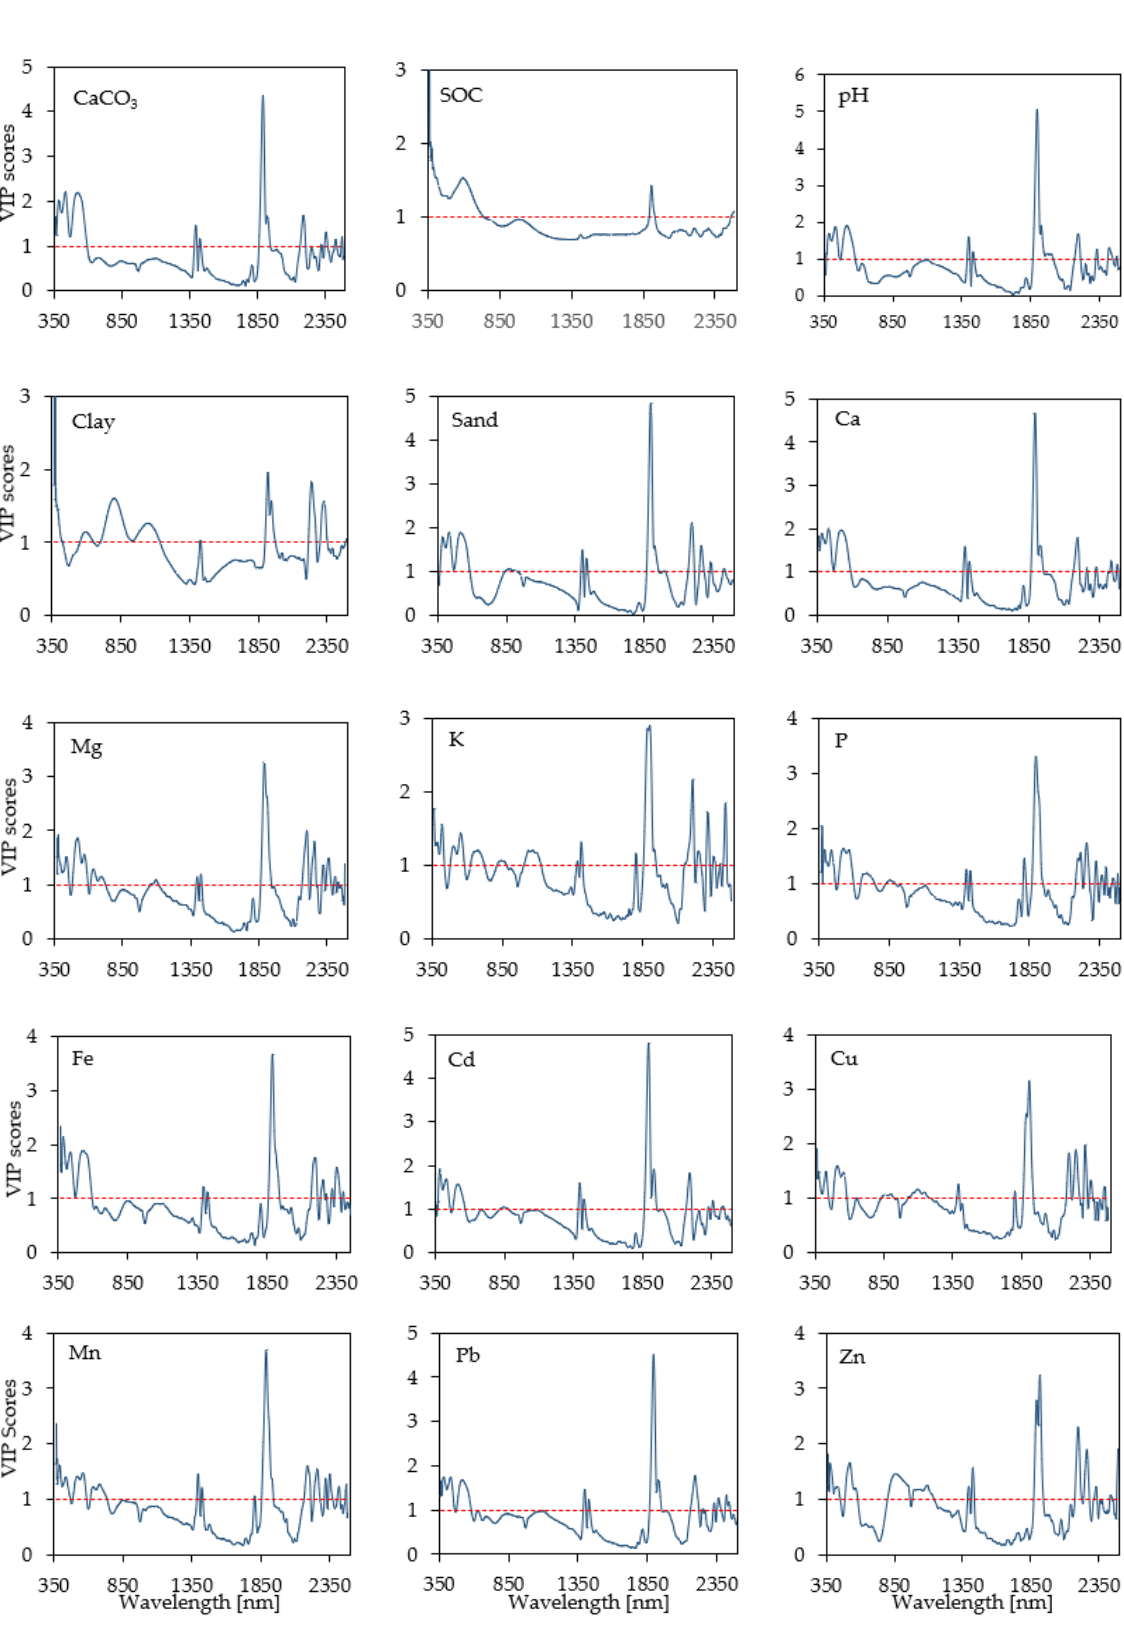
Figure 5. Variable importance in projection (VIP) scores associated with the PLSR models for the soil properties. The wavelength is considered as important if the VIP scores exceed the threshold value of 1 (dashed red line).